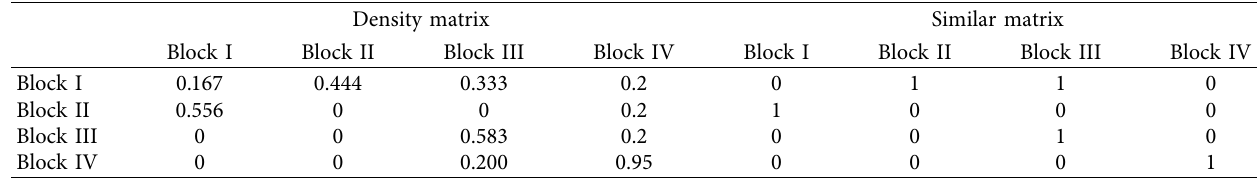
Figure 5: Correlation between the four sectors of the RECP national trade Table 3: RECP trade spatial connection network density matrix and similar matrix.